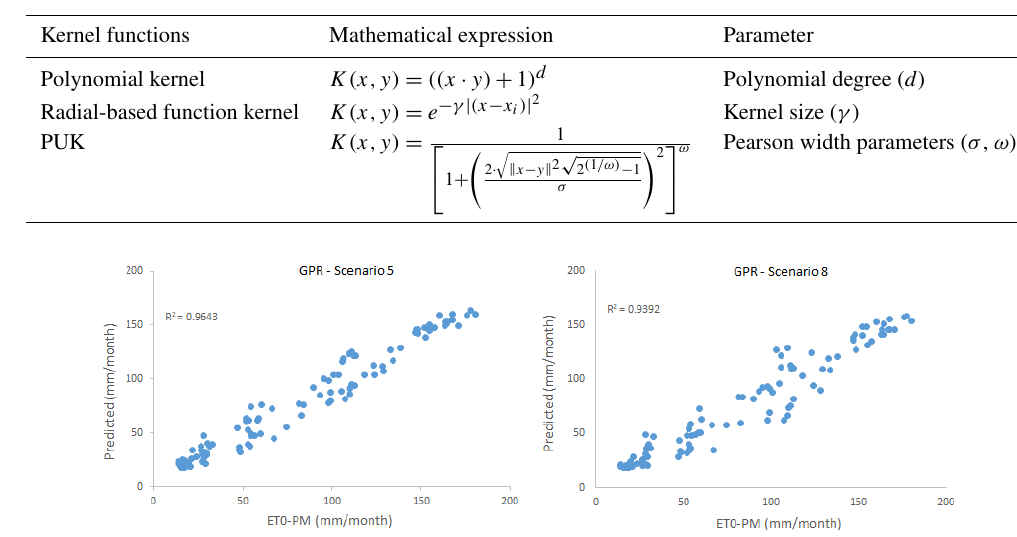
Figure 4. Scatter plots comparing GPR-estimated and FAO56PM-estimated ET 0 in scenarios 5 and 8.